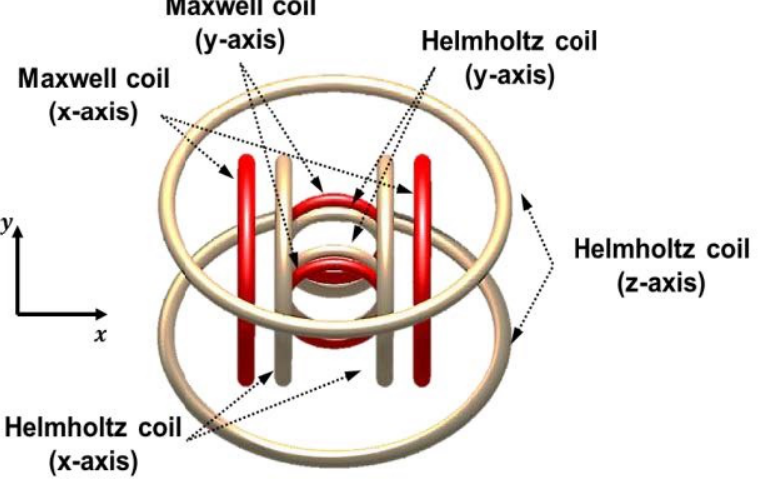
Figure 11. Schematic configuration of EMA system coils developed proposed by Park et al.